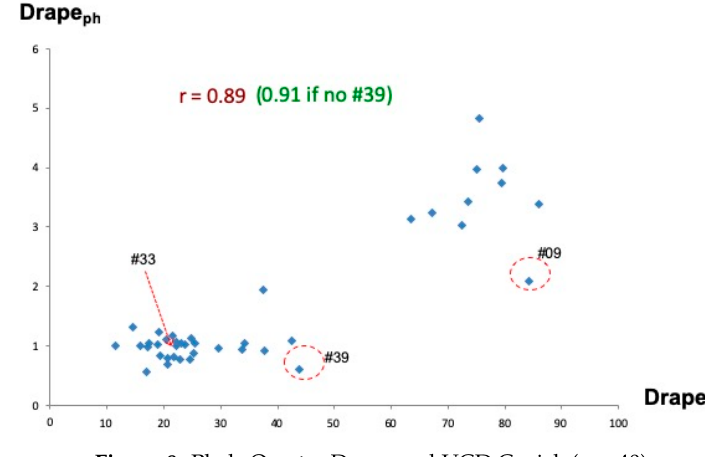
Figure 8. PhabrOmeter Drape and UCD Cusick (n = 40).